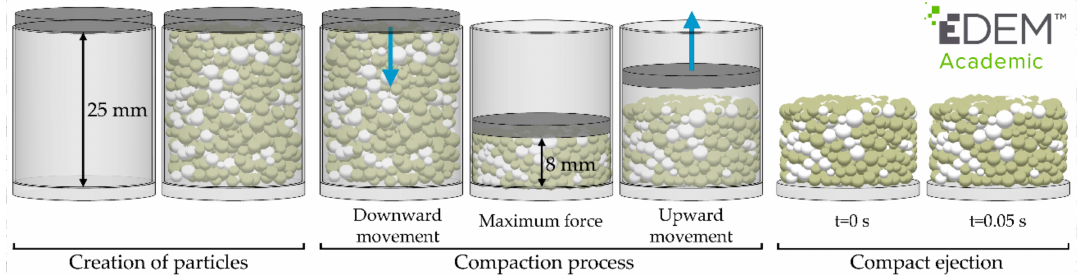
Figure 2. Stages of the simulated